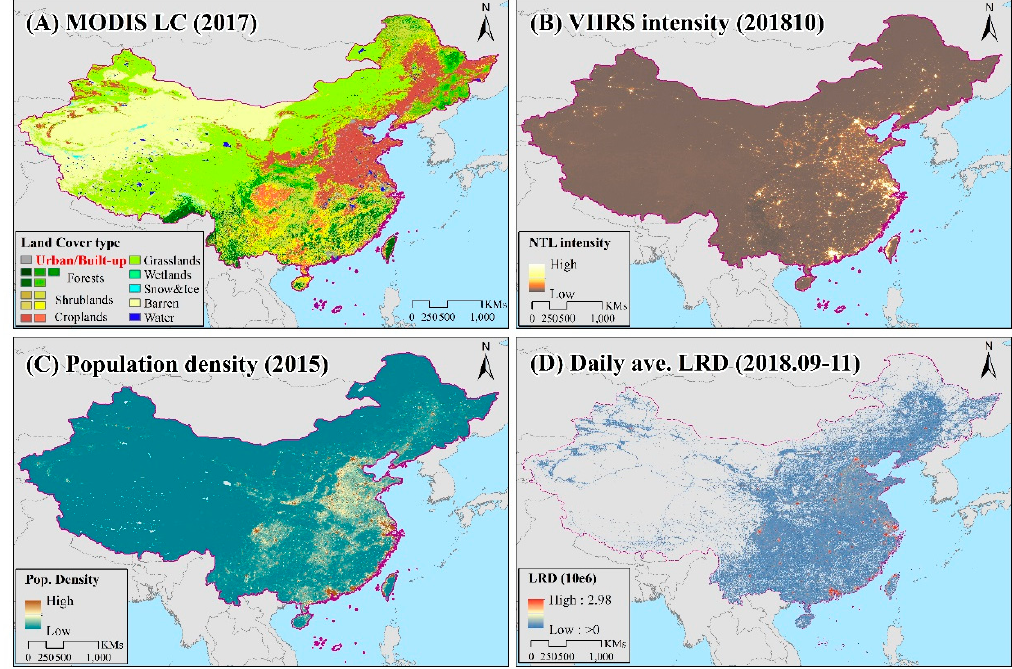
Figure 1. The basic situation of China, including (A) the Moderate Resolution Imaging Spectroradiometer (MODIS) land cover (LC) in 2017, (B) the Visible Infrared Imaging radiometer Suite—Day/Night Band (VIIRS/DNB) intensity in October 2018, (C) the population density in 2015, and (D) the Tencent location request density (LRD) during September to November in 2018.